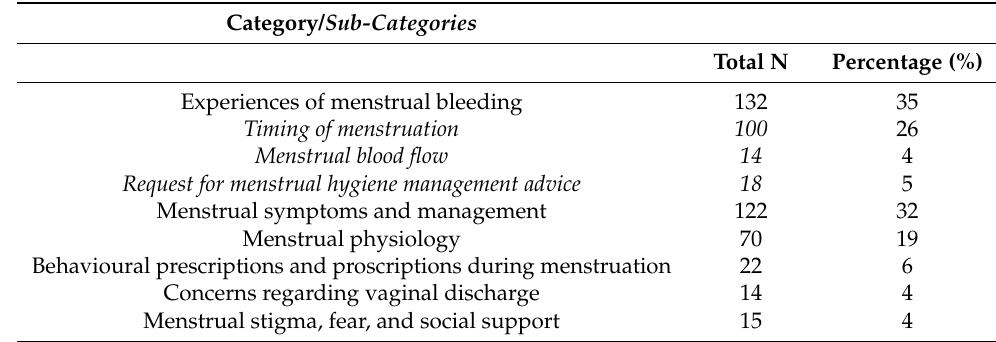
Table 1. Menstruation-related questions submitted by students in four schools in Bangladesh 2017–2018, reported by category/sub-category.